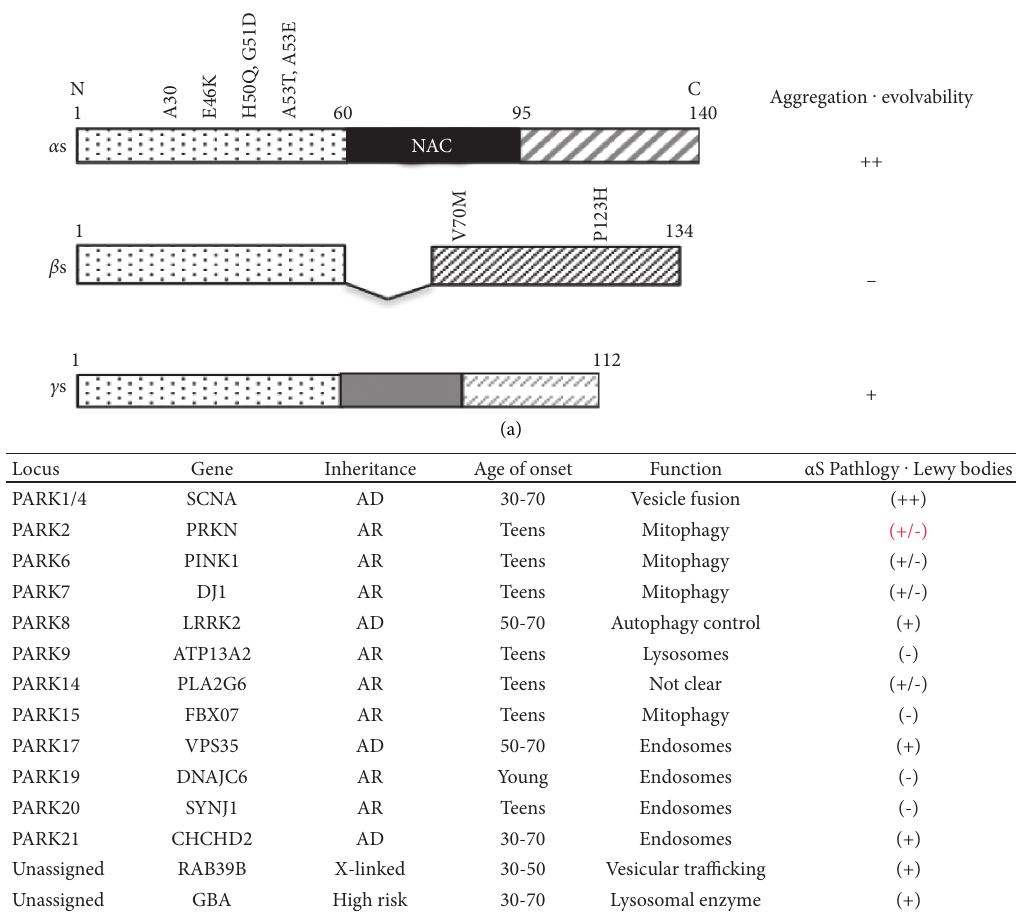
Figure 1: Description of α S and other PD risk factors. (a) Diagram of the synuclein family of peptides. α S has two related proteins, namely, β - and c S. While the N-terminal domains are highly homologous, the C-terminal regions are more divergent. The middle domain of α S, referred to as NAC, is highly amyloidogenic, [5], whereas that of c S is somewhat less amyloidogenic. In contrast, the NAC corresponding domain is naturally absent from β S. So far, six and two missense mutations have been characterized for α - and β S, respectively [5]. Since evolvability is supposed to depend on the protofibrillar form of APs, α S might exhibit greater evolvability associated with increased aggregation property compared to c S, while β S instead may negatively regulate α S evolvability through its buffering capacity. (b) Clas- sification of familial PD. Currently, more than twenty familial PD (PARK 1 ∼ 21) have been identified, most of which are associated with mutations of either AD- (PARK 1 and 4: SNCA; PARK8: LRRK2; PARK17: VPS35; and PARK 21: DNAJC13) or AR genes (PARK2: Parkin; PARK6: DJ-1; PARK7: PINK1; PARK9: ATP13A2; PARK14: PLA2G6; PARK15: FOXO7; PARK19: DNAJC6; and PARK20: SYNJ1). The former ones are usually late-onset (30–70 years old), frequently during postsenescent aging, whereas the latter ones are early-onset (teens) during the reproductive stage. The functions of the former gene products are related to cellular activity, such as vesicle fusion, mitochondria, autophagy/lysosomes, and endosomes, whereas the latter ones are involved in selective degradation of mitochondria, so called mitophagy. Neuropathologically, the former ones are associated with aggregation of α S and formation of Lewy bodies, whereas the α S pathologies in the latter are less clear, partially reprinted with modification from Singleton and Hardy (2019) [3] with